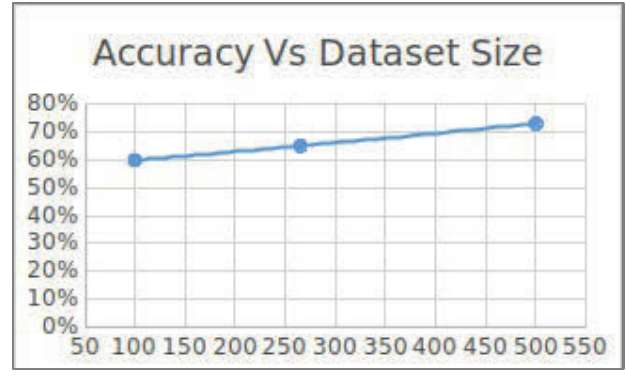
Fig. 3. Accuracy vs. dataset